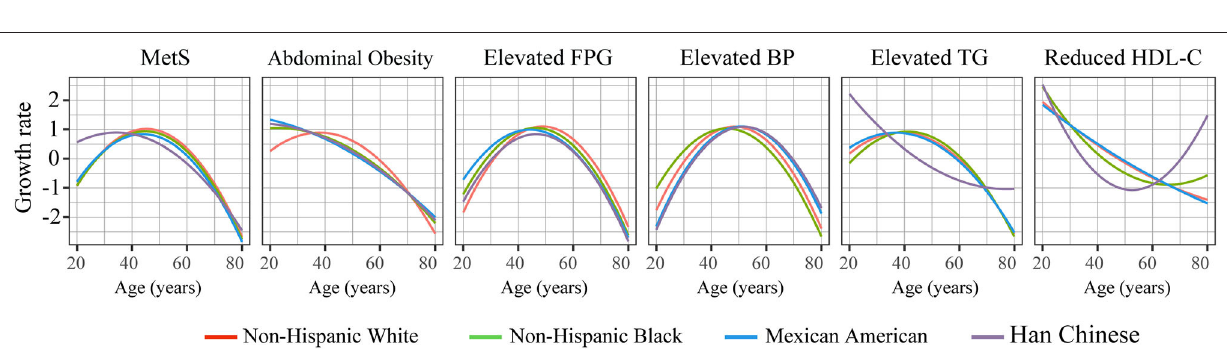
FIGURE 2 | The growth speed of the prevalence of MetS and its components with increased age. The speed at each age was estimated according to the cubic